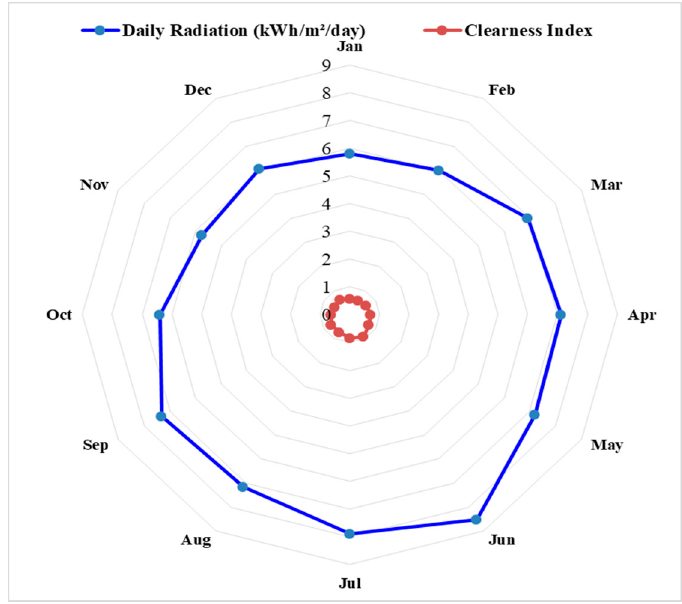
Figure 4. Monthly mean solar radiation for 12 months of the year.